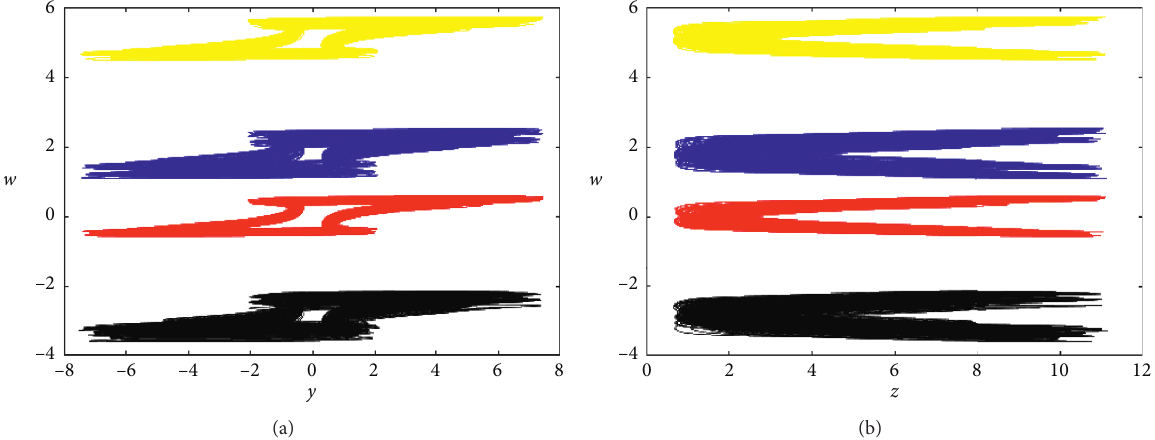
Figure 3: Phase portraits of coexisting infinitely many attractors in (a) y − w and (b) planes (the blue one starts from initial conditions ( 1 , 0 , 0 , 1 ) , the red one starts from ( 1 , 0 , 0 , − 1 ) , the yellow one starts from ( 1 , 0 , 0 , 4 ) , and the black one starts from ( 1 , 0 , 0 , − 4 )